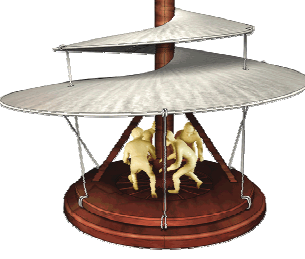
Figure 1 – Helixpteron - Leonardo da Vinci’s helicopter Рис . 1 – « Хеликсптерон » - винтокрыл Леонардо да Винчи Слика 1 – Хеликсптерон – хеликоптер Леонарда да